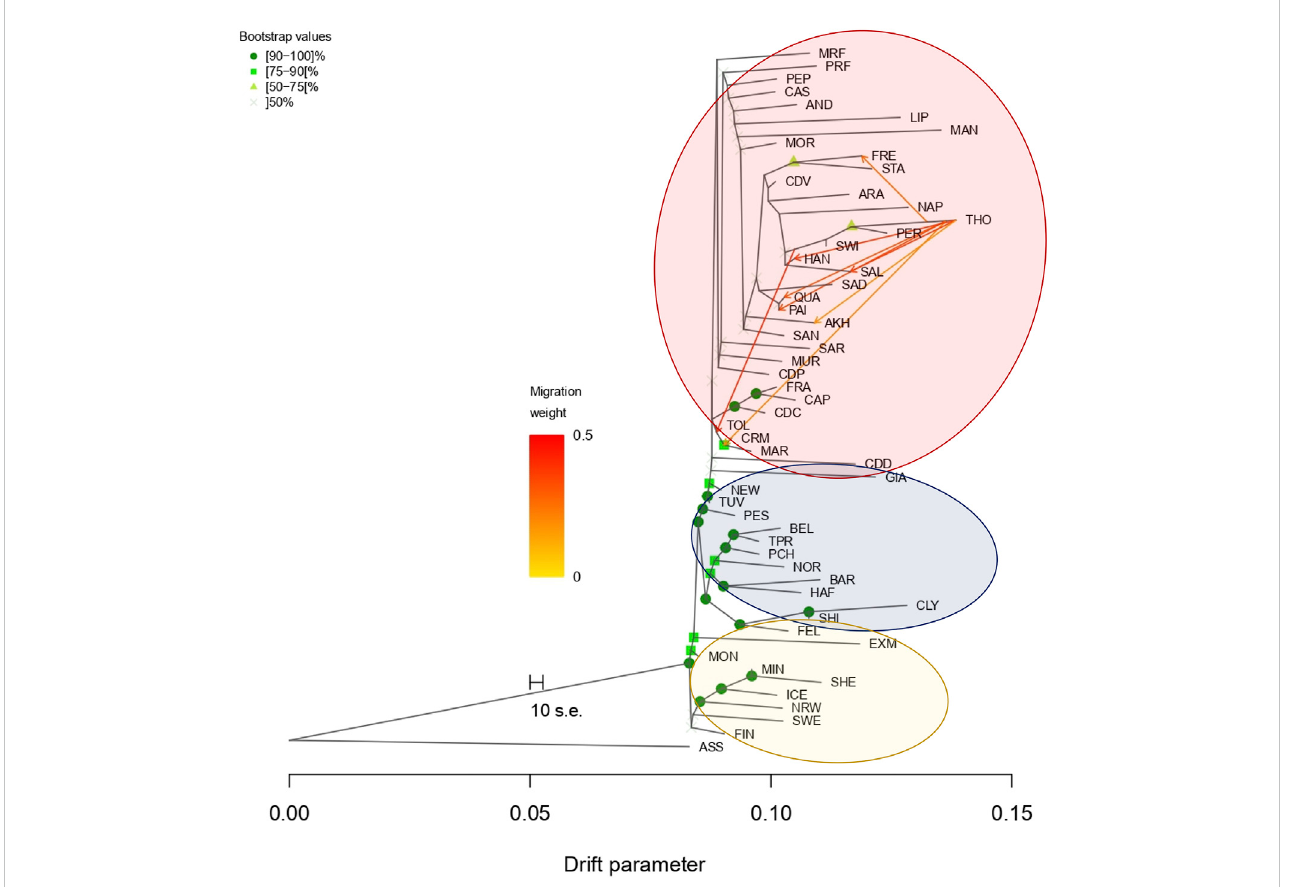
FIGURE 5 Gene fl ow analysis using TreeMix. Phylogenetic tree can only strongly validate coldblood breeds; gene fl ows are represented with arrows and the migration weight is differentiatedbythecolor intensity. Warmblood,coldblood,and pony clusters are highly observable.Full list ofused acronyms isavailable in Supplementary Table S1. Donkey population is identi fi ed with the acronym ASS.